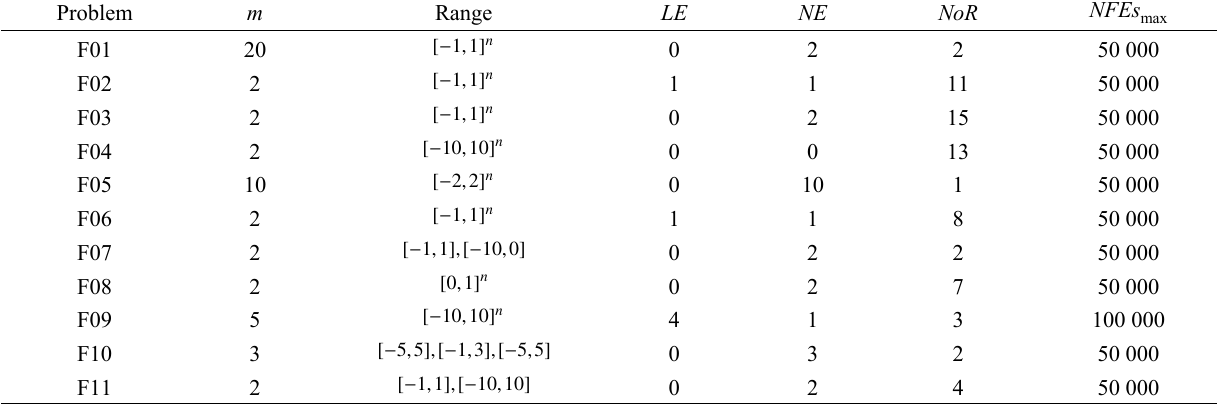
Table A1 Brief information of the test